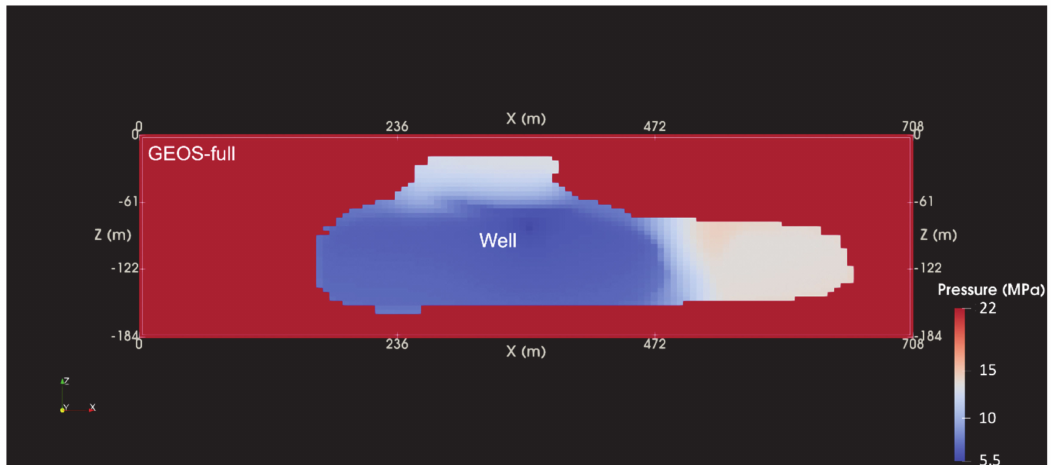
Figure 9. Pressure in the 3rd hydraulic fracture at 1000 days. Aperture in the fracture is the same as that shown in Figure 8 ( GEOS-full